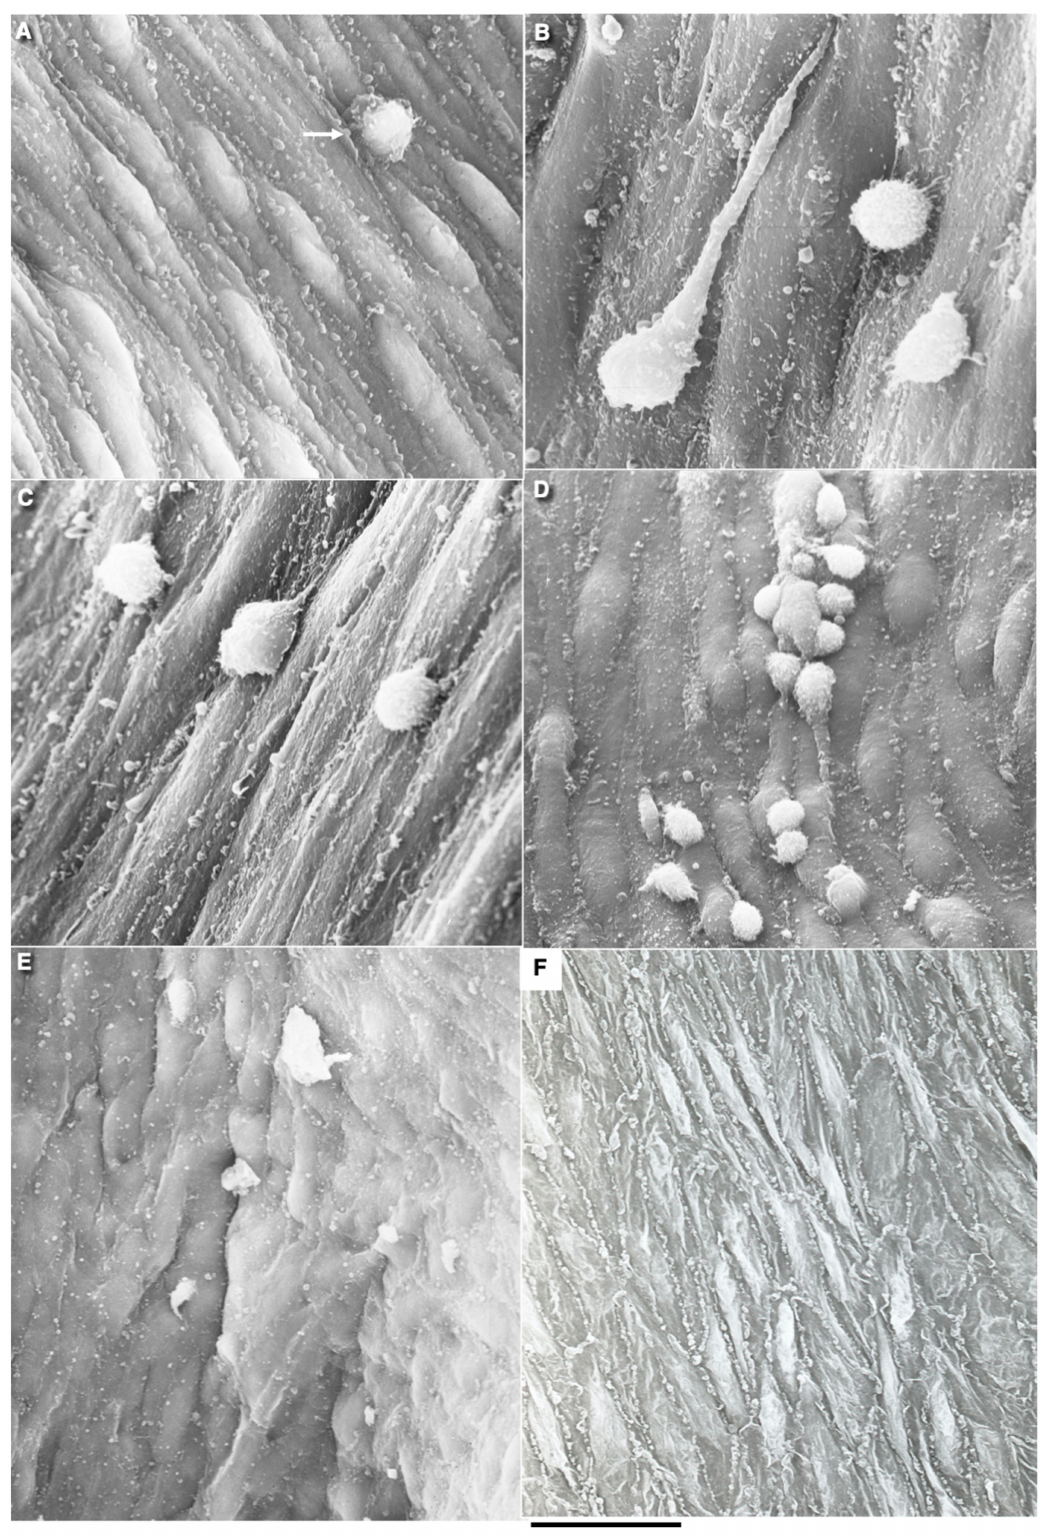
Figure 6. Surface of the endothelium in abdominal aorta after different influences. ( A ) Surface of ECs after the reparation of a single cryoinjury. Arrow indicates the leucocyte on the surface of ECs. ( B ) Multiple injury. ( C ) Single injury in old rats. ( D ) Single injury in hypertensive rats. ( E , F ) Surface of endothelium in hypertensive rats. Scale bars: 18 µ m ( A ); 10 µ m ( B ); 14 µ m ( C ); 22 µ m ( D ); 43 µ m ( E ); 30 µ m ( F